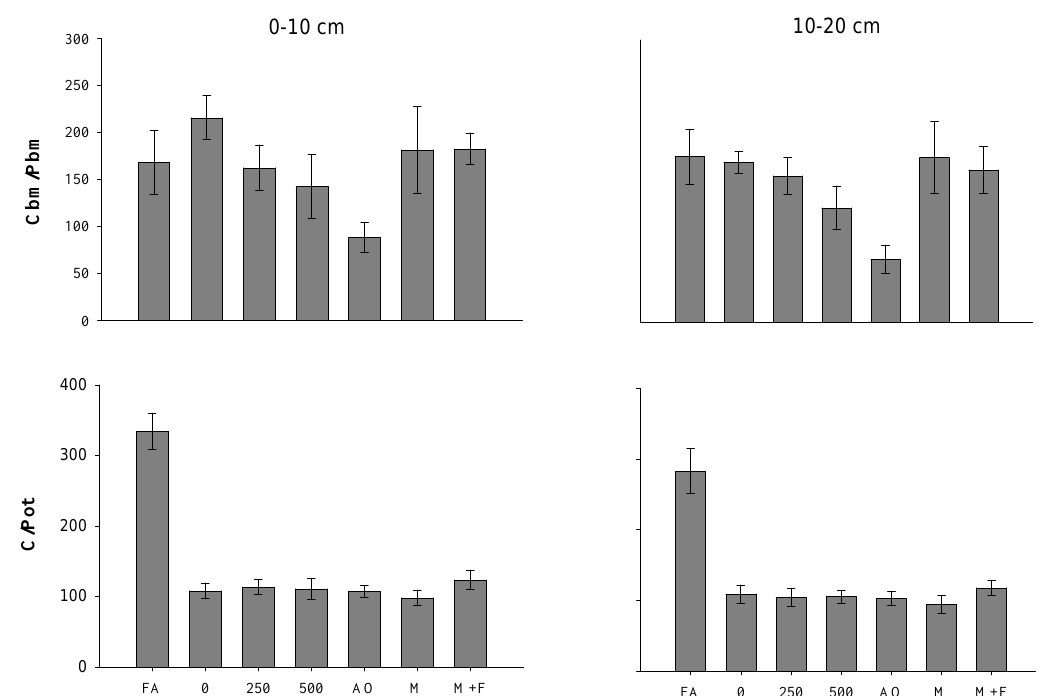
Figura 1. Médias dos valores das relações entre carbono e fósforo da biomassa microbiana (Cbm/Pbm); e carbono e fósforo orgânico total (C/Pot), nas profundidades de 0–10 e 10–20 cm. FA: Floresta Atlântica; 0: ausência de adubo orgânico e mineral; 250 e 500: 250 e 500 kg ha -1 de 4–14–8, respectivamente; AO: 40 m³ ha -1 adubo orgânico; M: milho M + F: milho + feijão. Barras inseridas nas colunas representam o erro-padrão em relação à média (n =